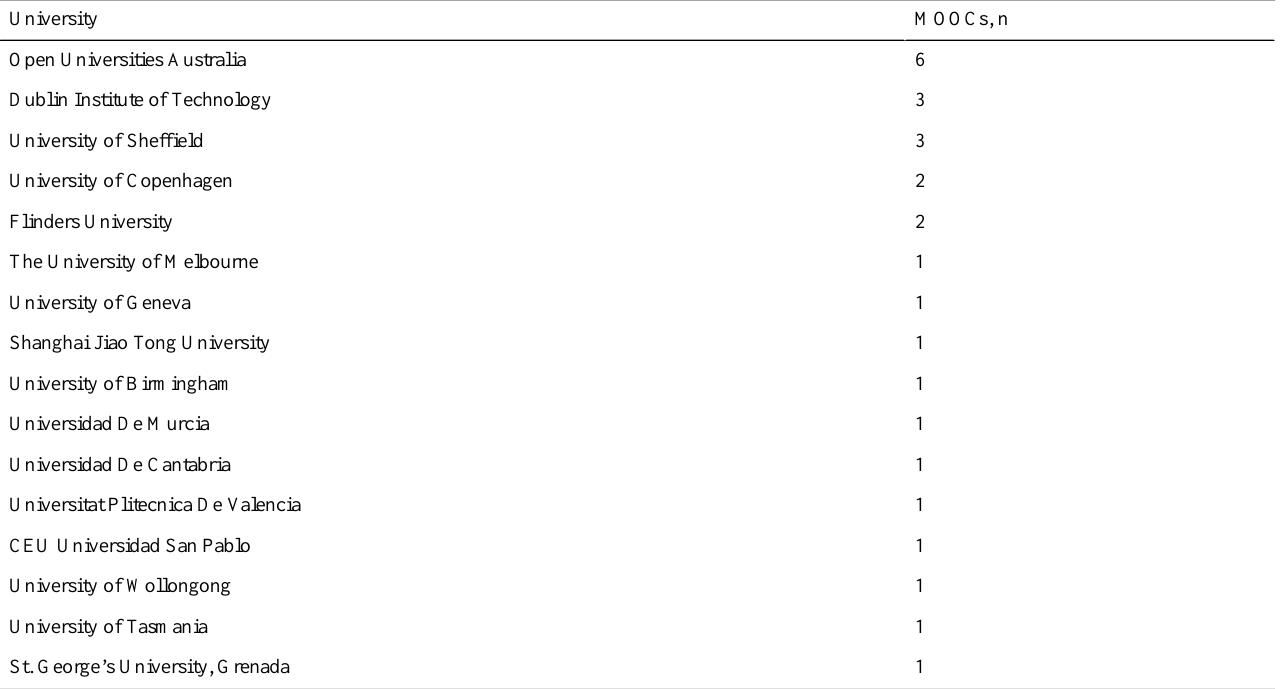
Table 5. MOOCs offered by universities outside North America (n=27).